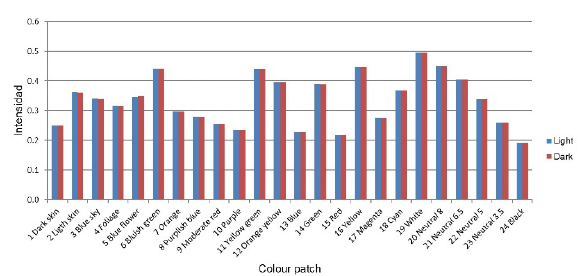
Figure 2. Intensity values for the two laser scannings acquired with a Leica ScanStation 2.